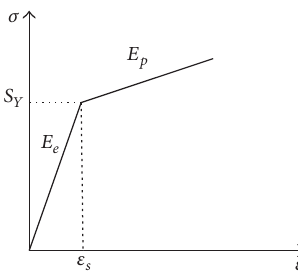
Figure 3: Bilinear stress-strain behavior for one-dimensional space.